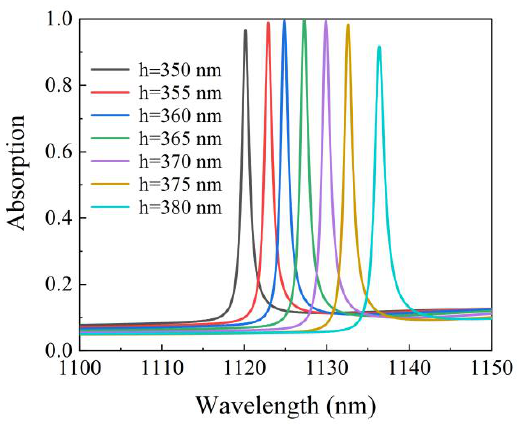
Figure 7. Absorption spectrum for different groove depths of Si grating.